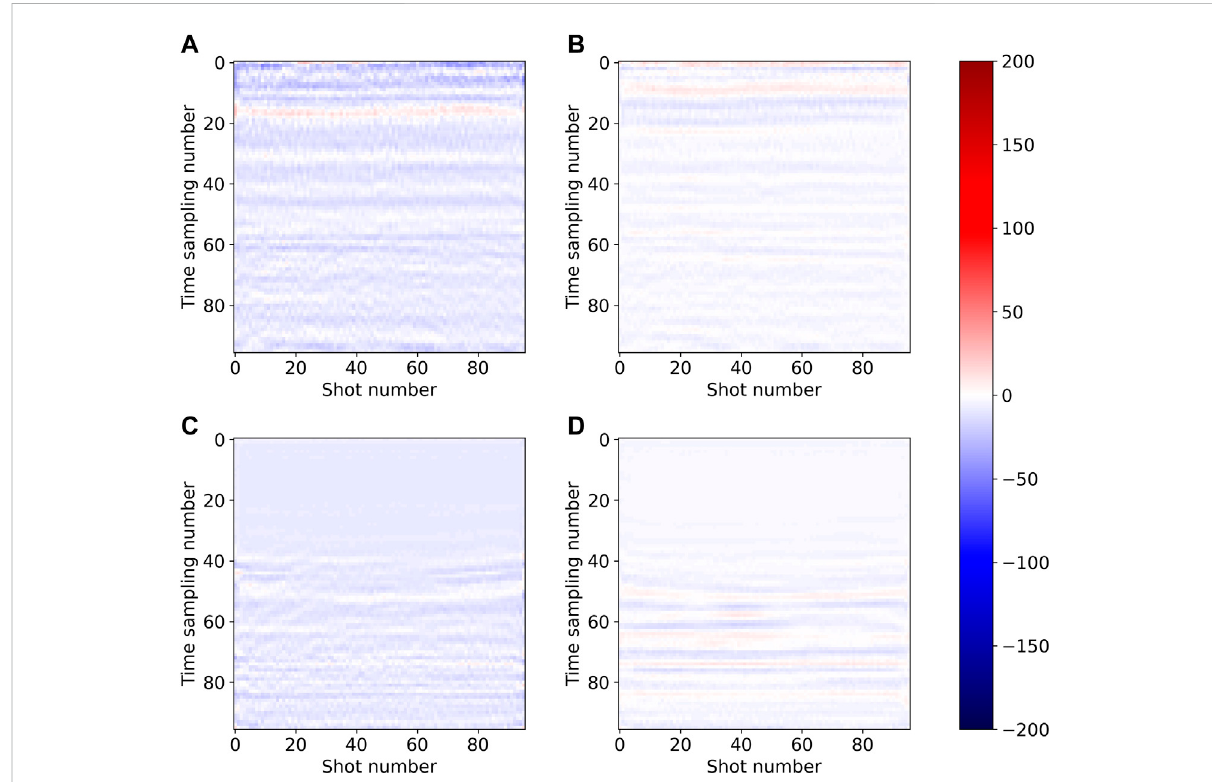
FIGURE 16 Residualof (A) UnetonNo.49receiverslice, (B) DS-UnetonNo.49receiver slice, (C) UnetonNo.24receiver slice(Figure14C),and (D) DS-Unet on No.24 receiver slice (Figure 14D).